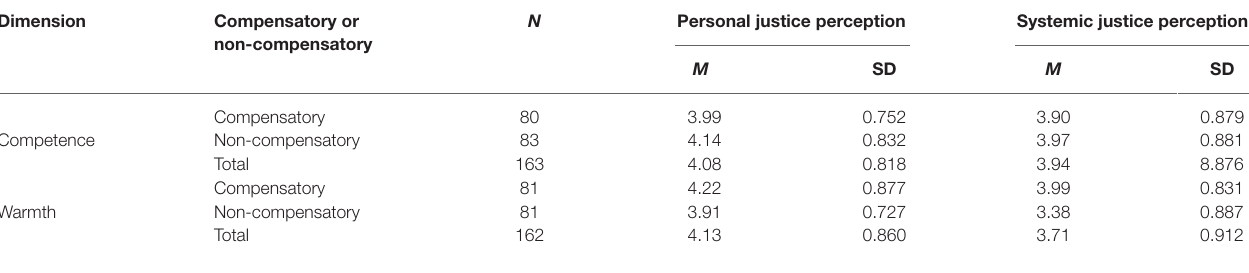
TABLE 2 | Social justice perception scores after activating compensatory stereotypes for different dimensions. Dimension